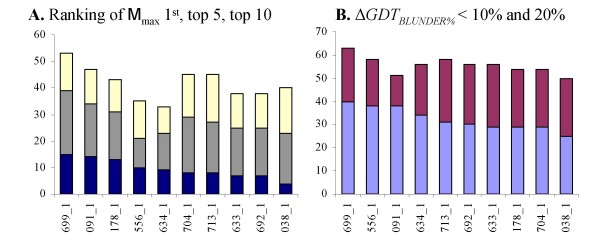
Recovery of Mmax using SetComplete. (A) number of targets where Mmax is ranked first (top of dark blue bar), in the top five (top of gray bar), and in the top ten (top of white bar). (B) number of targets where ΔGDTBLUNDER% is less than 10% (top of light blue bar) and less than 20% (top of purple bar). Only the first ten groups are shown in both graphs.